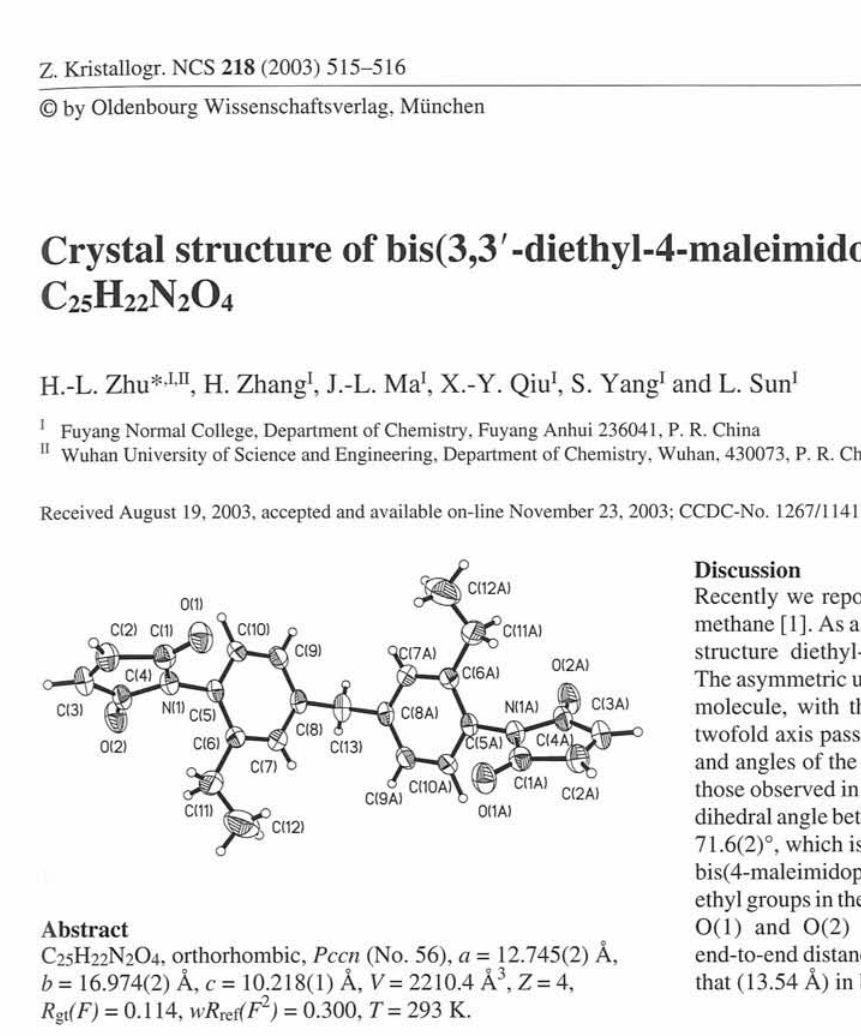
Table 1. Data collection and handling.